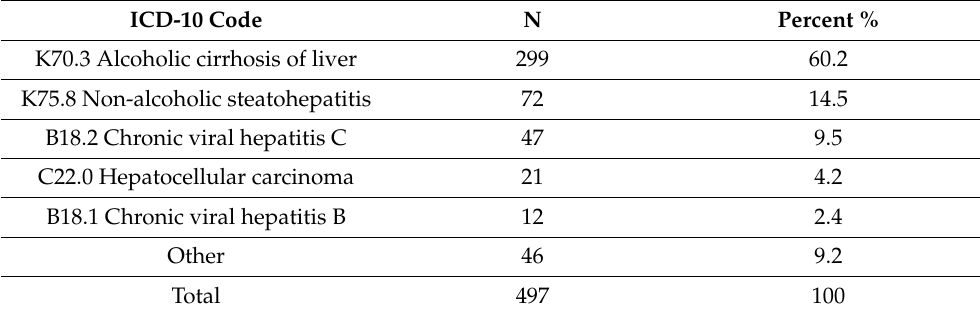
Table 1. Etiology of Liver disease.